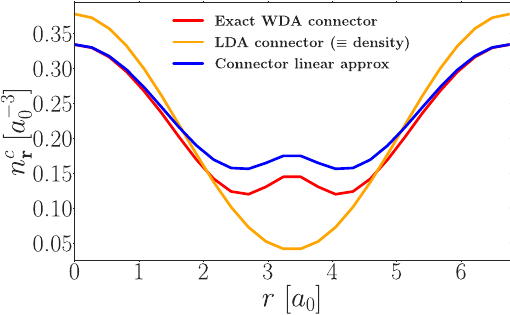
Fig. 2 Comparison of connector densities. Exact WDA connector Fig. 1 Target WDA xc potential, and approximations, for a system ð r ; ½ n (cid:2)Þ (red line). Coulomb cutoff n c ; WDA (red line), connector based on a linear expansion in the with periodic density. Target v WDA r xc density as given by Eq. (7) (blue line), and the density itself, at short-range (s.-r.): direct approximation (dotted green) and used corresponding to the local density approximation connector (yellow via the connector (dotted green with fi lled circles); linear expansion: line), for the periodic system of Fig. direct approximation (blue dashed) and used via the connector (blue dashed with fi lled circles); LDA (yellow line). Minimum and and 0 : 3776 a (cid:3) 3 , reciprocal lattice maximum densities are 0 : 0402 a (cid:3) 3 0 0 . vector a ¼ 0 : 93 a (cid:3) 1 0